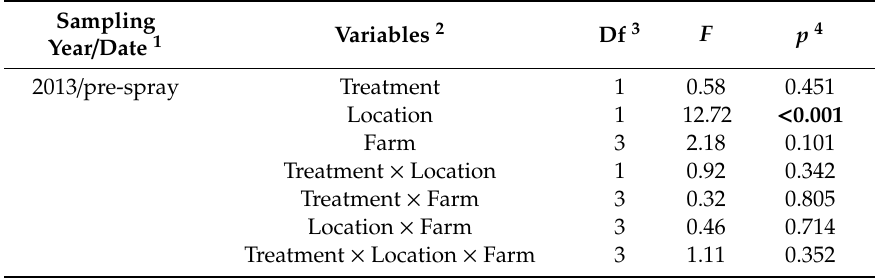
Table 1. Statistical output for the main and interactive e ff ects of baiting blueberry bushes with the aggregation pheromone grandisoic acid and the hostplant odor benzaldehyde (Treatment), their proximity to the forest (Location), and farm on the proportion of oviposition-scarred fruit by Conotrachelus nenuphar